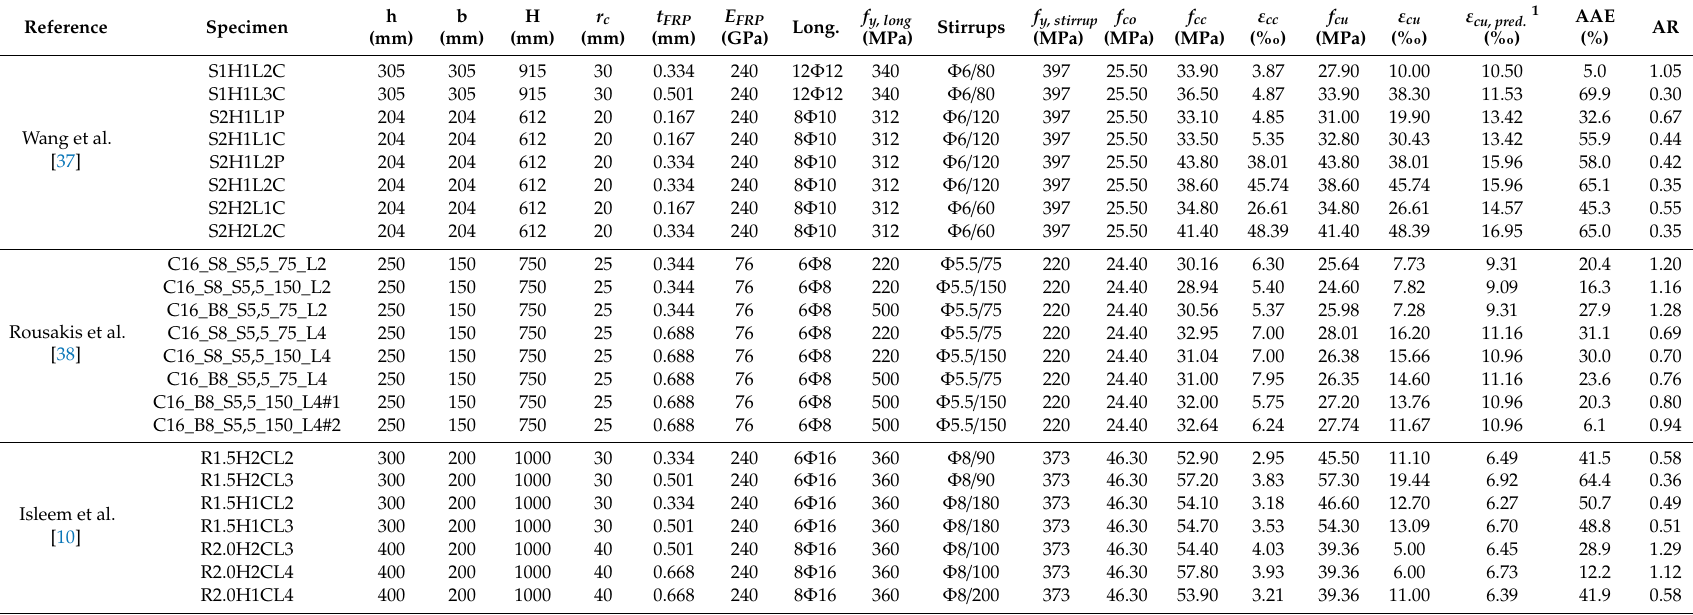
Table 1. Geometrical and mechanical data of 44 reinforced concrete (RC) square and rectangular columns under cyclic axial